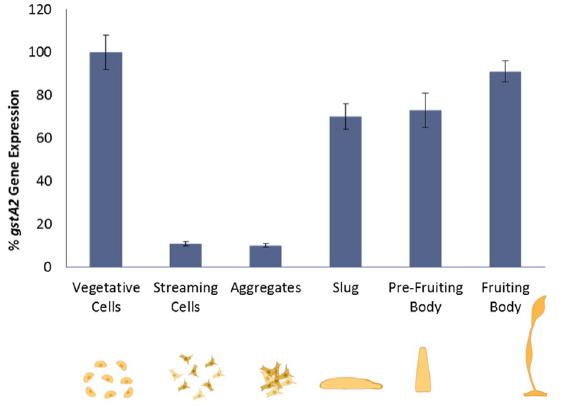
Fig 6. Transcriptional analysis of gstA2 at different developmental stages of D . discoideum . In comparison to vegetative cells, gstA2 expression is lower at initial stages of development and increases during stages of differentiation and morphogenesis. Histograms represent at least three experiments (n = 3) performed in triplicate (mean ± SD, p < 0.05).